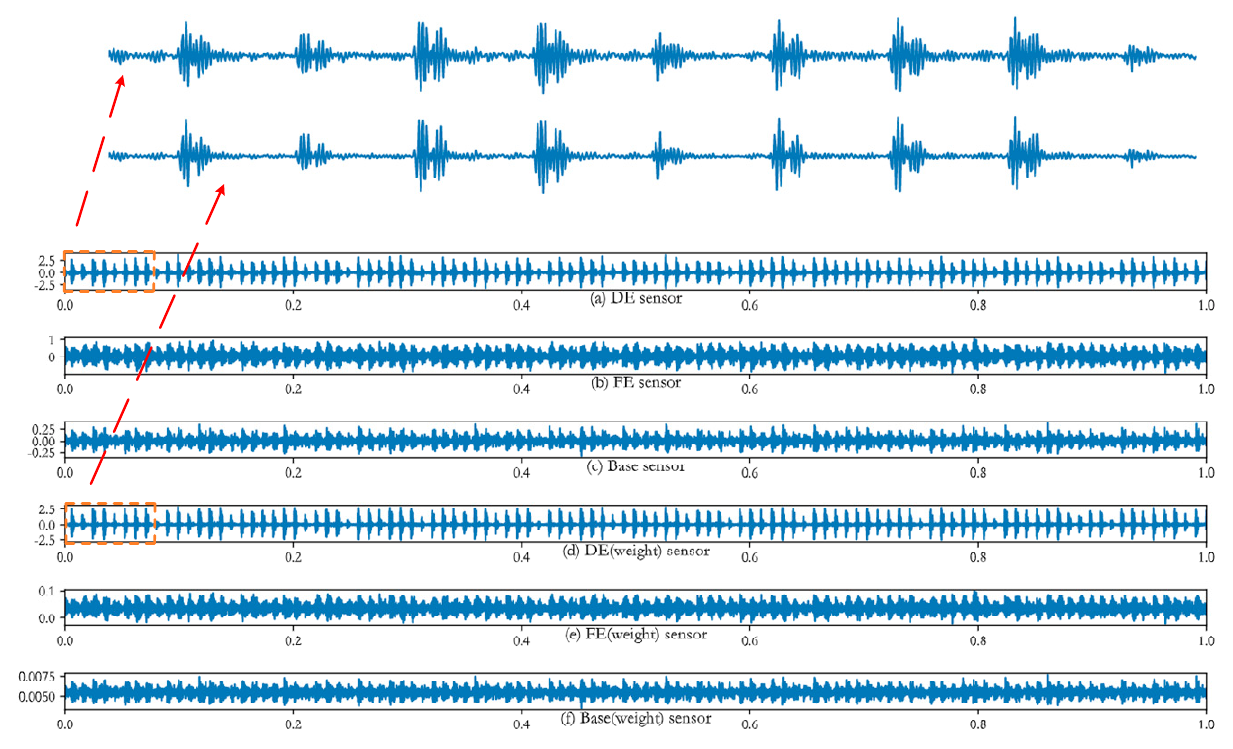
Figure 7. Time domain graph of outer race fault. ( a − c ) are the unweighted data obtained by the sensors located at DE, FE, and base, respectively, ( d − f ) are the corresponding weighted data.